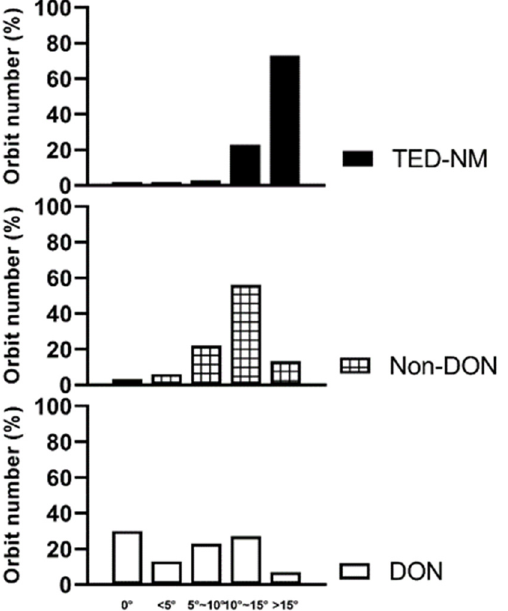
Figure 7. Population distribution of the angle between the lateral rectus and optic nerve.